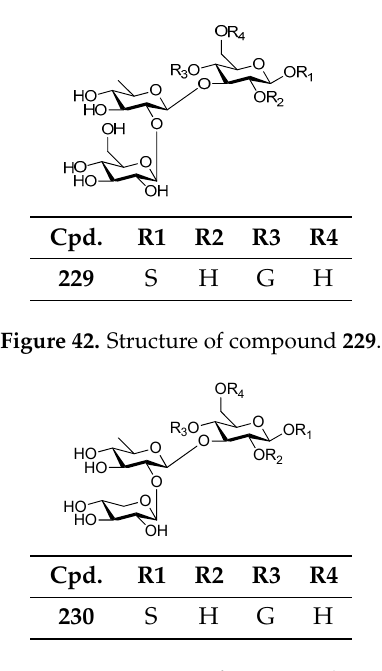
Figure 43. Structure of compound 230.